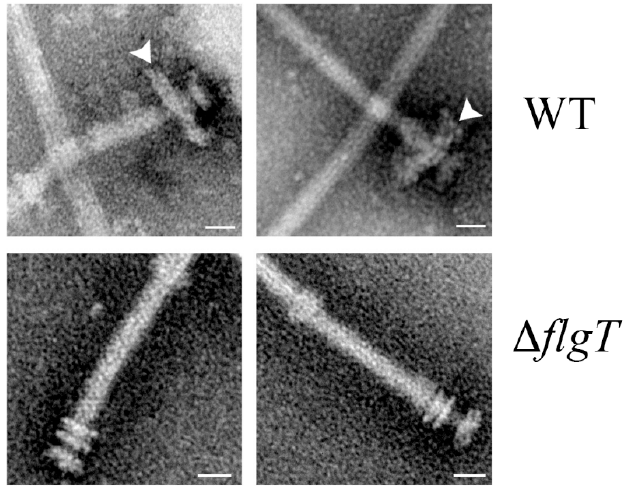
Figure 5. Electron micrographs showing isolated filament-hook-basal bodies from wild type cells expressing Fla1 and from a mutant lacking FlgT. White arrows denote the H-ring Bar = 20 nm [56]. The flagellar motor of R. sphaeroides also includes the protein FlgP that is an outer membrane lipoprotein essential for flagellum formation [57]. In this work, we observed that FlgP interacts with itself suggesting that it could form an oligomeric structure. It was also proposed that FlgP could form the basal ring that is located under the outer membrane, as it has been previously observed in C. jejuni